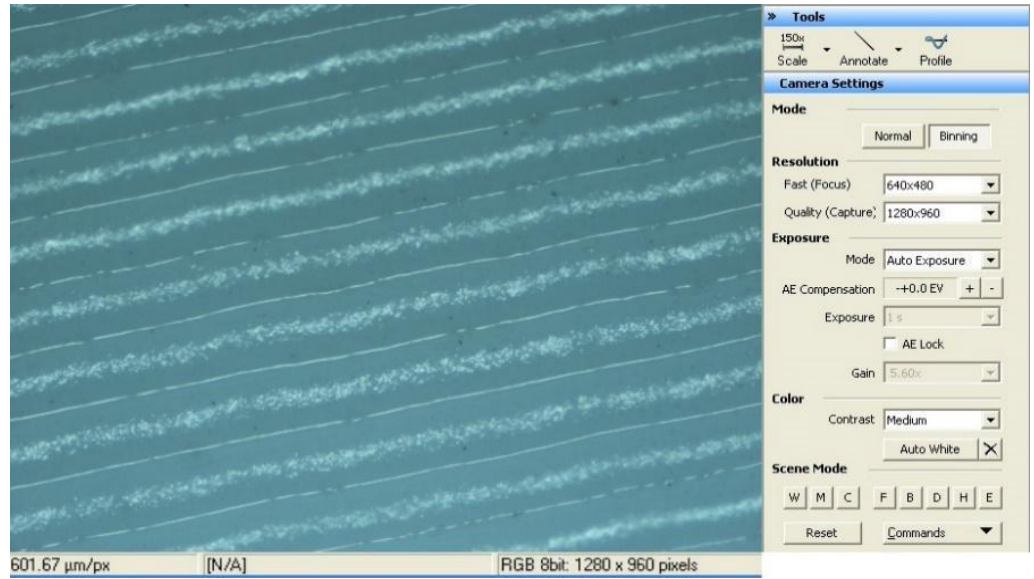
Figure 3: An image of the flat surface for sample 1 taken by microscope with magnification factor of